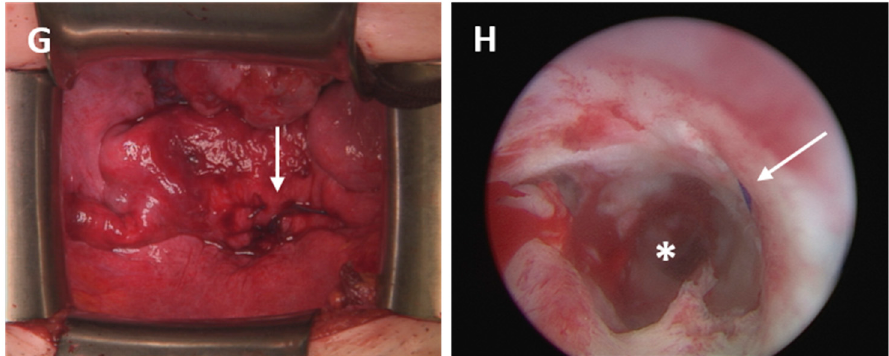
Figure 4. Case 6. ( A ) Transabdominal sonography; * uterus without hematometra; arrow depicts endometrium of 9 mm; # suspected rudimentary horn or myoma. ( B ) Abdominal magnetic resonance imaging: + full bladder, * suspected ovarian cyst 6 × 4 cm, # dilated rectum; arrow shows suspected T-shaped uterus without hematometra; arrowhead shows vagina; no connection from vagina to uterus. ( C ) Situs during abdominal laparotomy: arrow marks T-shaped uterus, * left side ovarian cyst of 10 cm diameter, suspicious for endometrioma ( D ) Incision of the suspected endometrioma and discharge of typical chocolate-like blood (arrow). ( E ): Insertion of an overhold clamp from the vagina (arrow) establishing a connection between the vagina and uterus. ( F ): Insertion of a 14 Ch-silicon catheter (arrow). ( G ) Uterovaginal anastomosis established by circular, non-resorbable Prolene 2.0 sutures (arrow). ( H ) Hysteroscopy after 5 weeks; sufficient uterovaginal anastomosis; * cavum uteri; arrow shows blue non-resorbable Prolene 2.0 suture.